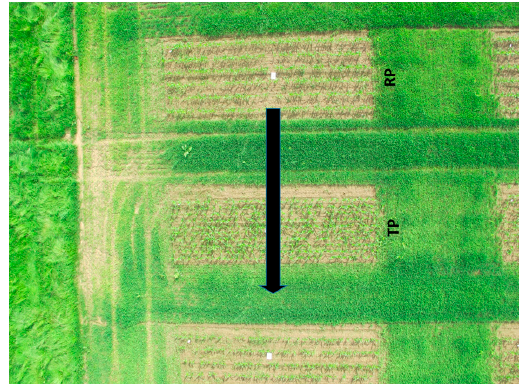
Figure 1. Part of the trial design, where black arrow indicate the flight direction of the unmanned aerial vehicles (UAVs) and illustrate the field section that was captured in the image (in general three plots). The abbreviations RP and TP indicate row planting and triangular (equidistant) planting. DINA4 posters (210 × 297 mm 2 ) labeled with the plot number were placed on each plot. Images were taken with a Canon G12 digital camera (Canon, Tokyo, Japan) with 1/1.7 inch CDD sensor, 10 megapixels, 28-mm focal length, an image quality of 180 pixels/inch, triggering time of 281 milliseconds, f-stop of 2.97 and disk size of 4.91 MB mounted on the octocopter. Images were captured in auto mode due to changing light conditions and to avoid wrong ISO (light sensitivity of the camera sensor) the, f-stop and shutter speed settings. Despite the stable mounting of the camera